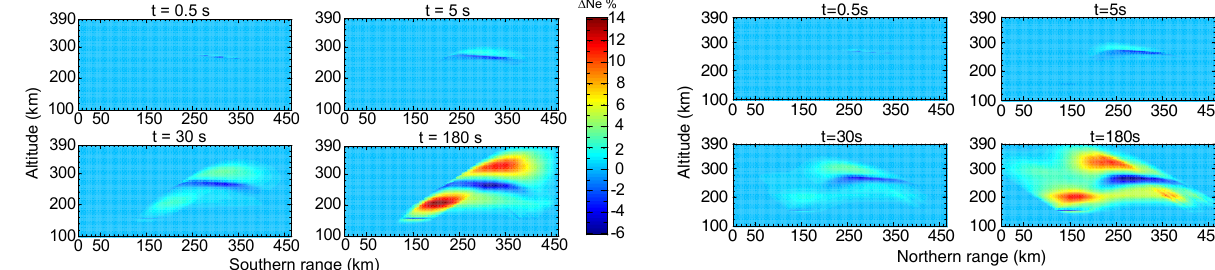
Figure 4. The evolution of the ionospheric electron density changes in the center meridian plane with heating wave incidence parallel to the magnetic field line at different heating duration times.